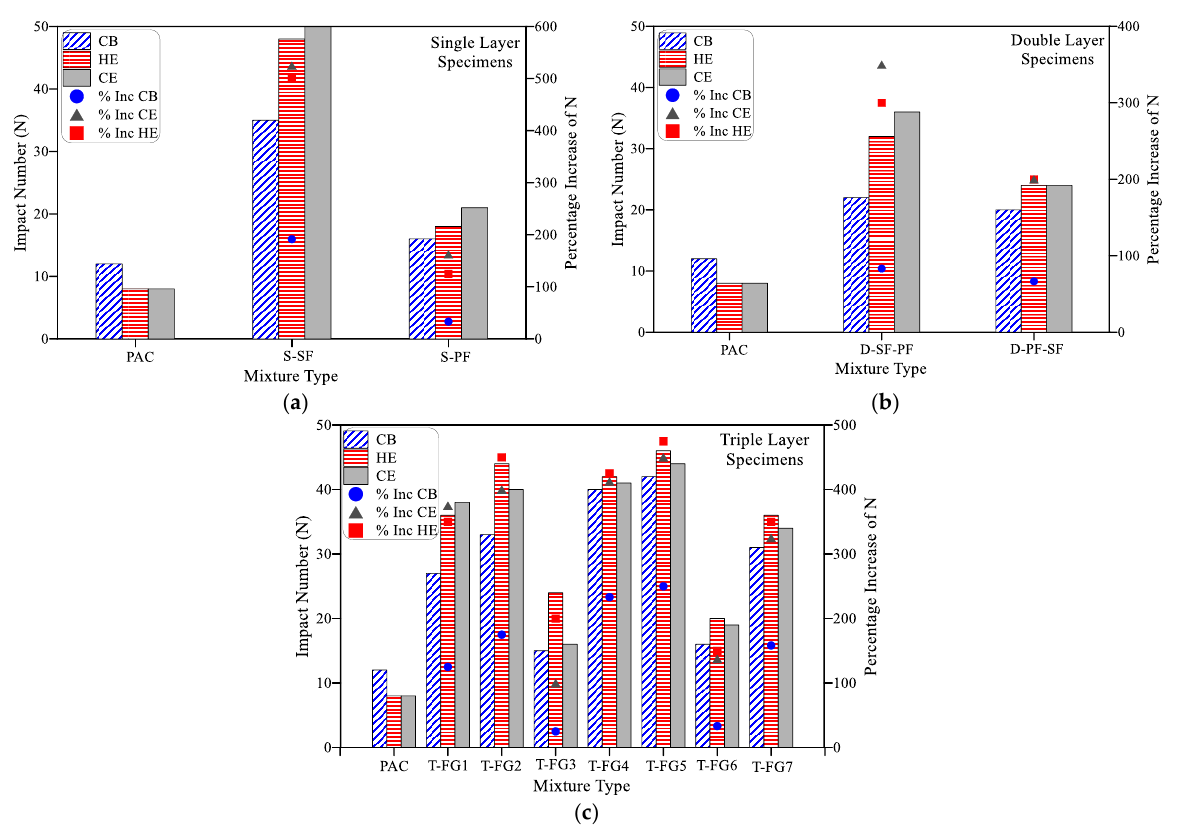
Figure 9. Effect of needle type on the failure impact number (N) of the projectile impact test. ( a ) Single layer specimens, ( b ) Double layer specimens, ( c ) Triple layer specimens.